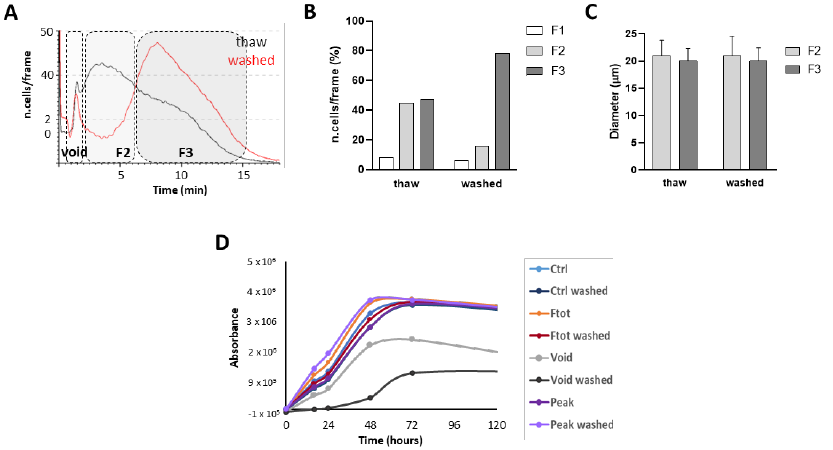
Figure 6. Representative figure of the fractogram of SW620 thawed cells in freezing medium (thaw in the black curve) and after the washing step (washed in the red curve) ( A ), showing a different retention time between the conditions. The profile was analyzed on three fractions: void (F1), F2, and F3. Thawed cells suspended in the freezing medium showed a two-peak distribution, splitting the main population into the two hypothetical fractions F2 and F3, while 80% of washed cells exit in F3 ( B ). Dimensional analysis showed smaller cells in F3 compared to F2 and no difference between the two conditions ( C ). When proliferation was monitored using Alamar blue assay, absorbance was measured very 24 hours and plotted for each fraction ( D ).